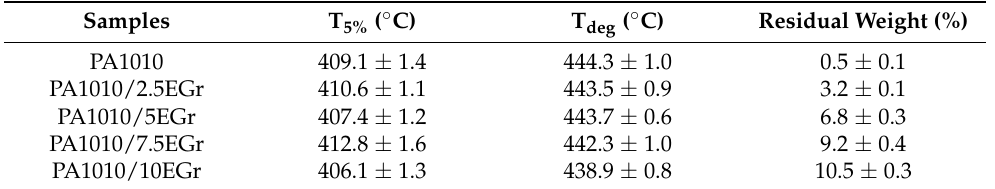
Figure 5. Thermomechanical properties of PA1010/EGr composites as a function of temperature, ( a ) storage modulus (E’) and ( b ) dynamic damping factor (tan δ ).